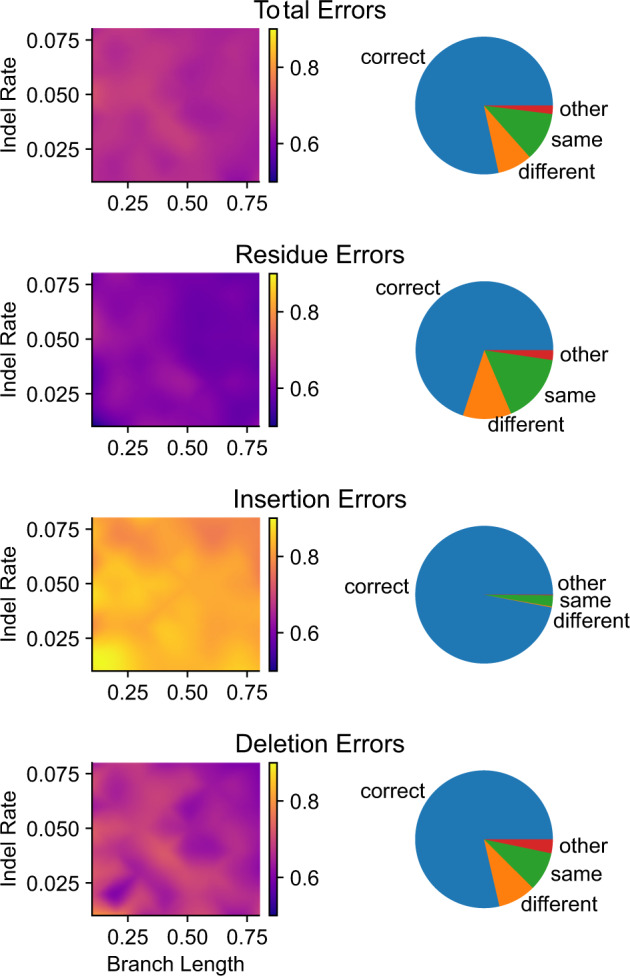
“Majority-rule” explains the majority of cases in which alignment–integration improves ASR error rates. We simulated protein sequences along a simplified three-taxon phylogeny, varying the branch length and indel rate (see supplementary fig. S12, Supplementary Material online). Ancestral sequences were inferred using seven different sequence-alignment methods and alignment–integration. Total- (top), residue-, insertion-, and deletion- (bottom) errors were calculated by comparing inferred ancestral sequences to the correct simulated ancestral sequence. Here, we consider only those cases in which a single sequence-alignment method produces an ASR error that is “repaired” by alignment–integration. Left panel: For each branch length (x axis) and indel rate (y axis), we plot the proportion of alternative sequence-alignment methods that inferred the correct ancestral state when one sequence-alignment method generated an ASR error that was not found in the alignment-integrated ancestral sequence. Right panel: Across all simulation conditions, we consider all cases in which a sequence-alignment method makes an error, and that error is repaired by alignment–integration. We report the proportion of such cases in which 1) the majority of alternative sequence-alignment methods infer the correct ancestral state (“correct”; blue), 2) the majority of alternative sequence-alignment methods infer an incorrect ancestral state, but that state is different from the original error (“different”; orange), 3) the majority of alternative sequence-alignment methods infer the same incorrect ancestral state (“same”; green), and 4) other scenarios (“other”; red).